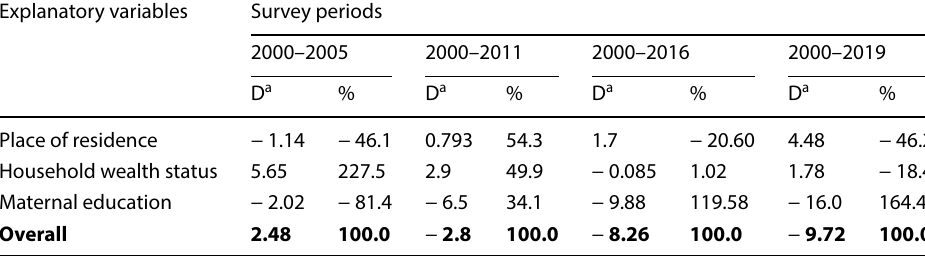
Table 5 Trends in socioeconomic inequalities in undernutrition by key drivers in Ethiopia,